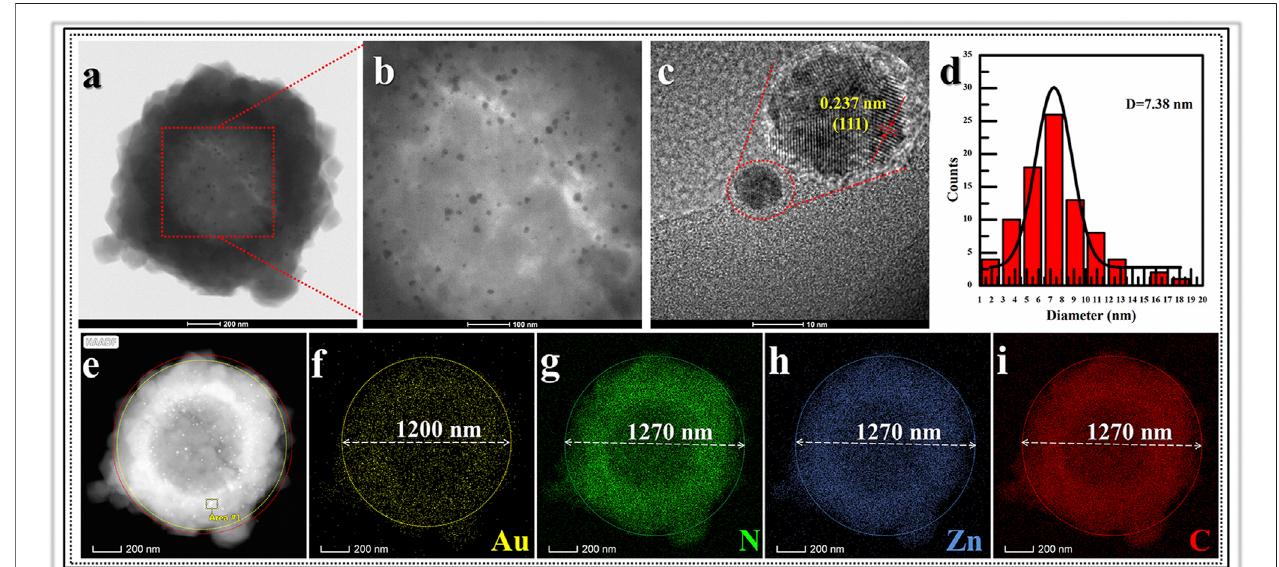
FIGURE 3 | TEM images for (A) Void|(Au)ZIF-8|ZIF-8 and its (B) partial magni fi cation image; (C) images of lattice fringes of Au nanoparticles and its (D) statistical image of the size distribution; (E) EDS-HAADF mapping images of (F) Au element; (G) N element; (H) Zn element and (I) C element.